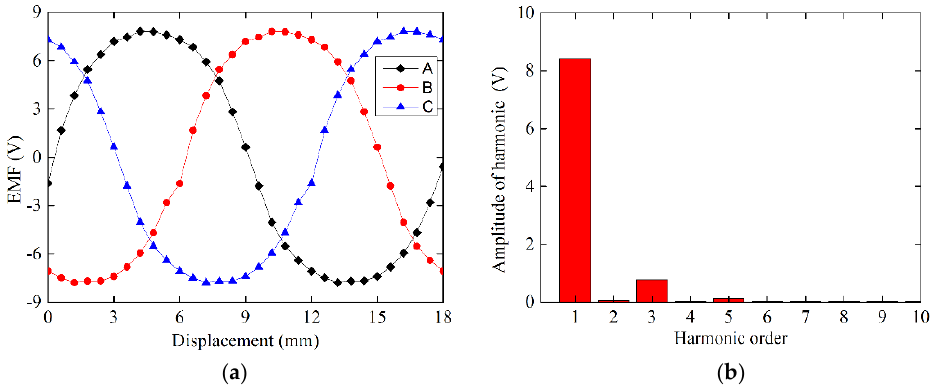
Figure 5. EMF and its harmonics ( a ) Waveforms; ( b ) Harmonics components.